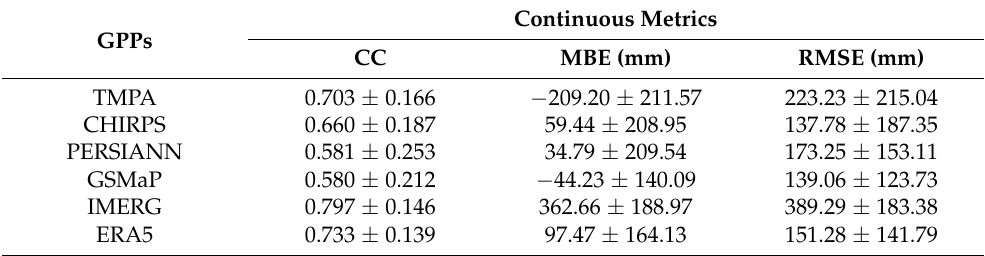
Table 5. Continuous metrics calculated from yearly accumulated precipitations values of the GPPs and synoptic stations at the station level.